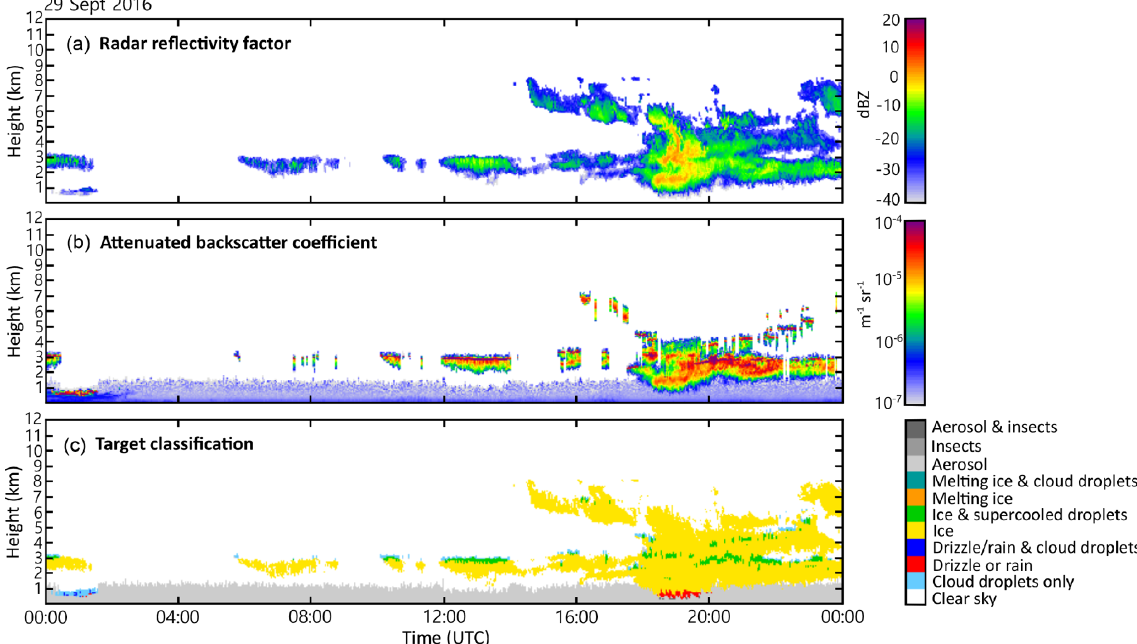
Figure 3. Radar reflectivity factor (a) , lidar backscatter coefficient, (b) and Cloudnet target classification (c) on 29 September 2016; AWIPEW observatory at Ny-Ålesund.